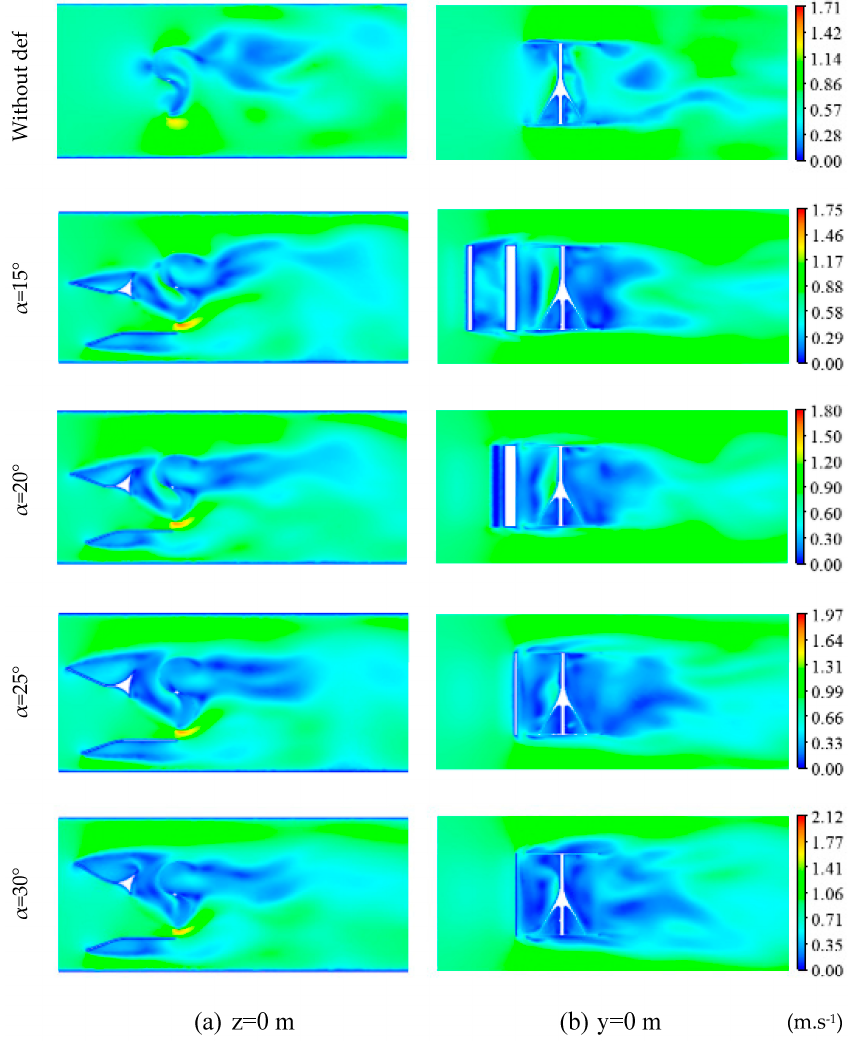
Figure 11. Magnitude velocity distribution for different deflection angles. For the same axial position z = 0 and for a y coordinate ranging from y = − 0.3 m to y = 0.3 m, different velocity magnitude profiles are generated to follow the evolution of the velocity for each transversal plane defined, respectively, by the x-coordinate value x = − 0.3 m, x = − 0.08 m, x = 0.08 m and x = 0.3